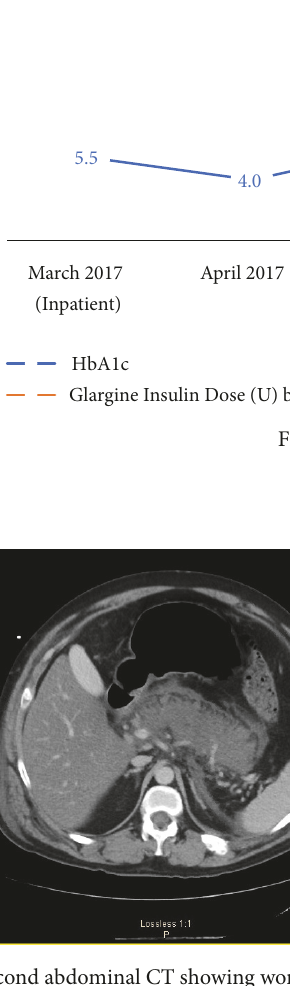
Figure 2: Second abdominal CT showing worsening